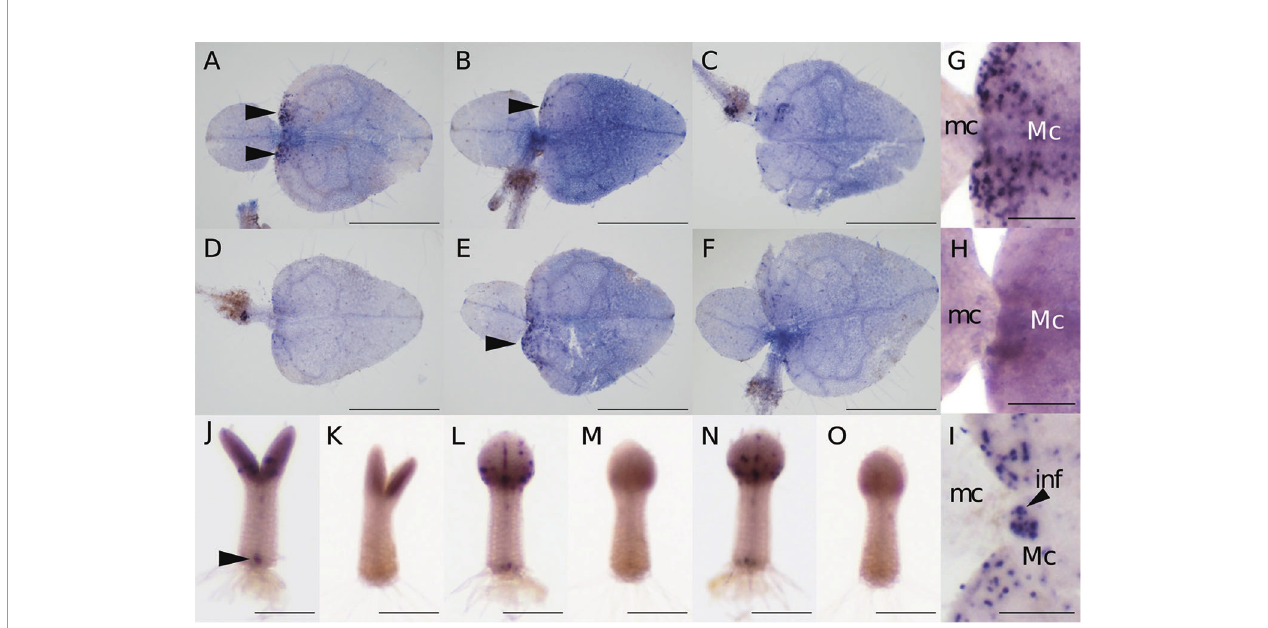
FIGURE 3 | Mg-CYCB1 expression pattern and meristem positions. (A – F) WMISH of Mg-CYCB1 using an antisense probe with fi xation in 4% PFA/15% DMSO (A, D) , 4% PFA/1.25% glutaraldehyde (B , E) , or 4% PFA/1.25% glutaraldehyde/15% DMSO in PBST, respectively. Cell wall enzyme treatment was performed for 1 h (A – C) or 3 h (D – F) . Black arrowheads indicate signals in the lamina of macrocotyledons. (G – O) Mg-CYCB1 expression pattern at different developmental stages. (G, H) Proximal part of the macro- and microcotyledon in an anisocotyledonous individual (17 DAS). (G) Antisense probe. (H) Sense probe. (I) Proximal part of the macro- and microcotyledon at the reproductive stage (38 DAS). (J – O) Whole plants at 7 DAS with identical cotyledon size. (J, L, N) Antisense probe. The black arrowhead indicates signals in the distal part of the petiolode. (K, M, O) Sense probe. (J, K) Frontal view. (L – O) Side view. inf , in fl orescence; mc , microcotyledon; Mc , macrocotyledon. Bar = 1 mm in (A – F) , 200 µm in (G – O)